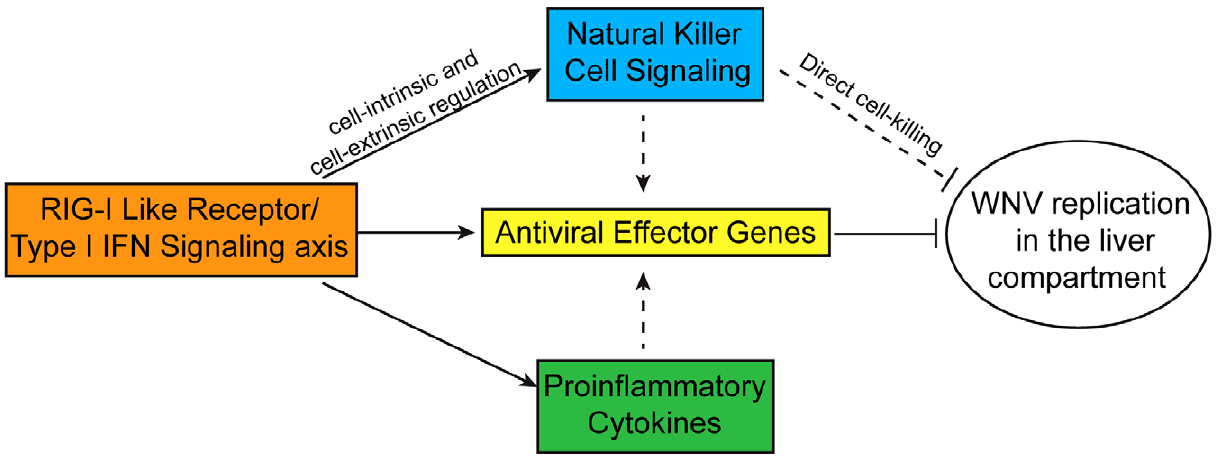
Figure 9. A model illustrating the host signaling pathways that regulate liver tropism to WNV. Upon WNV infection, the RLRs trigger expression of type I IFN, leading antiviral effector gene expression, pro-inflammatory cytokine induction, and activation of NK cells and related signaling pathways. Antiviral gene expression can further be amplified by natural killer cells and induction of pro-inflammatory cytokines, such as TNF- a and IFN- c . A combination of antiviral gene expression and natural killer cells, through direct cell lysis, participate in regulating WNV replication in the liver.